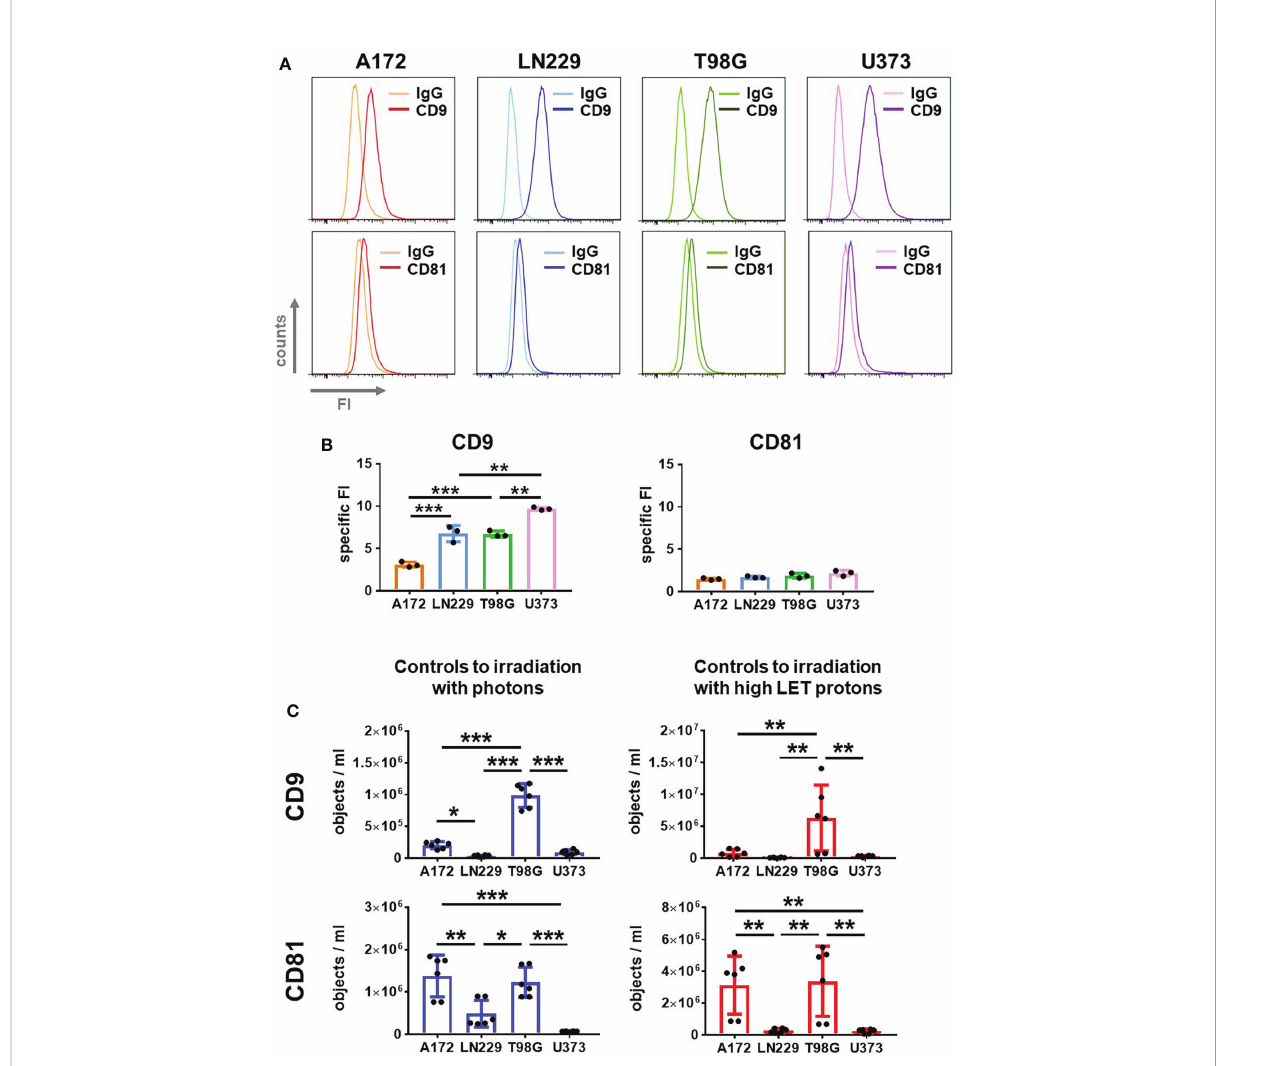
FIGURE 4 Glioblastoma cells secrete CD9 and CD81-positive EVs. (A, B) A172, LN229, T98G and U373 glioblastoma cells were permeabilized and stained with fl uorophore-coupled antibody against CD9 or CD81 before analyzing by fl ow cytometry. As control, idiotype-matched antibodies (IgG) were used. Representative histograms showing fl uorescence intensity (FI) are presented in (A) , while speci fi c FI was calculated in (B) . N=3, **p < 0.01; ***p < 0.001. (C) 24 h after plating glioblastoma cells, medium was replaced by 2 mL of EV-free culture medium. Supernatant was collected after 72 h EVs in supernatant were quanti fi ed using IFCM analyses. Objects numbers in supernatants used as non-irradiated controls in irradiation experiments with photons (blue bars) and protons (red bars) were compared. N = 6. *p < 0.05; **p < 0.01; ***p <